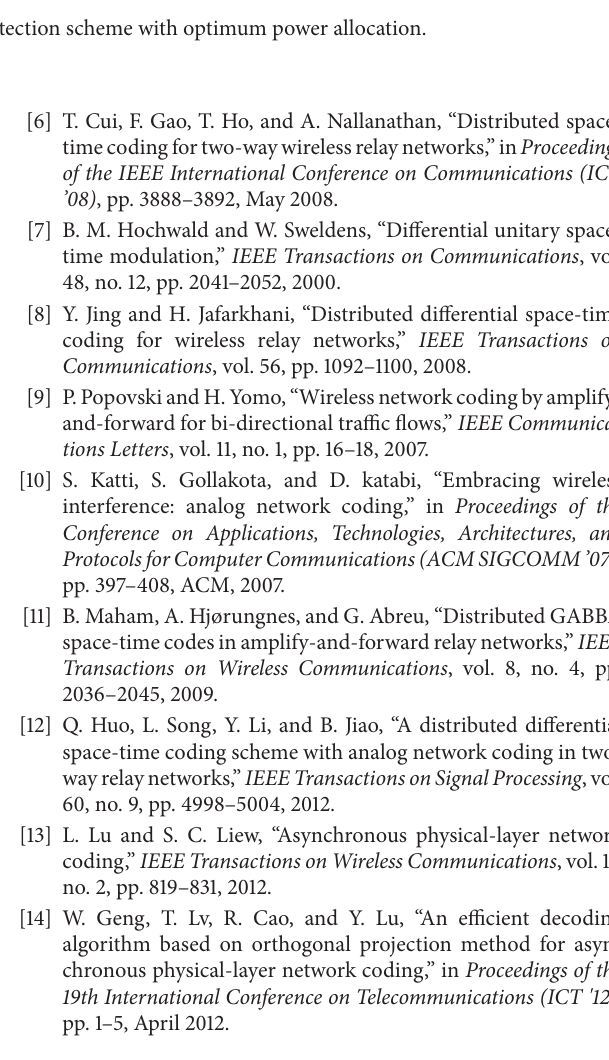
(b) Case II: 𝜎 2 𝑓 = 10,𝜎 2 𝑔 = 1